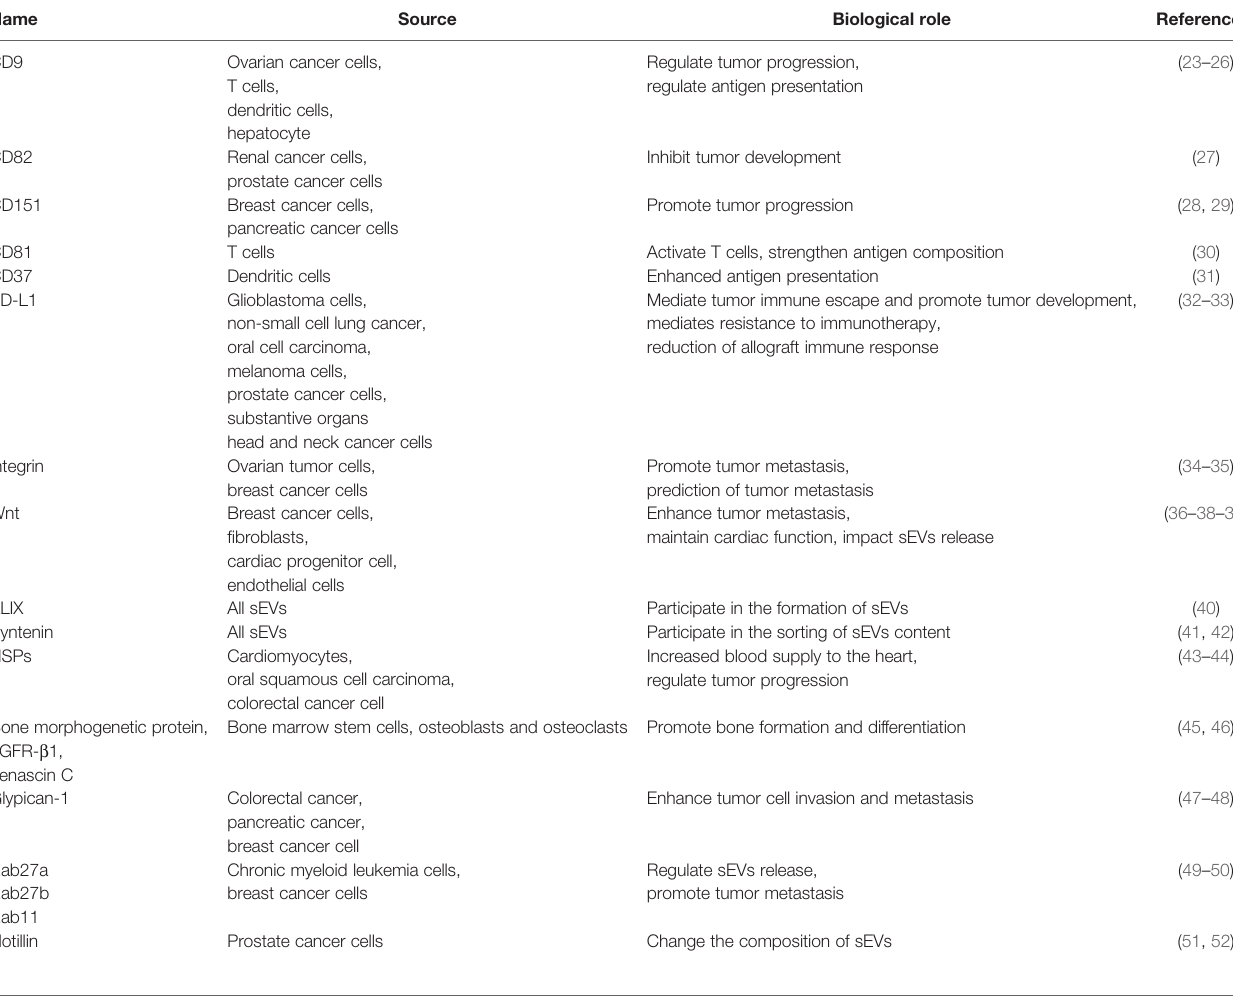
TABLE 2 | Expression location and biological function of sEV membrane